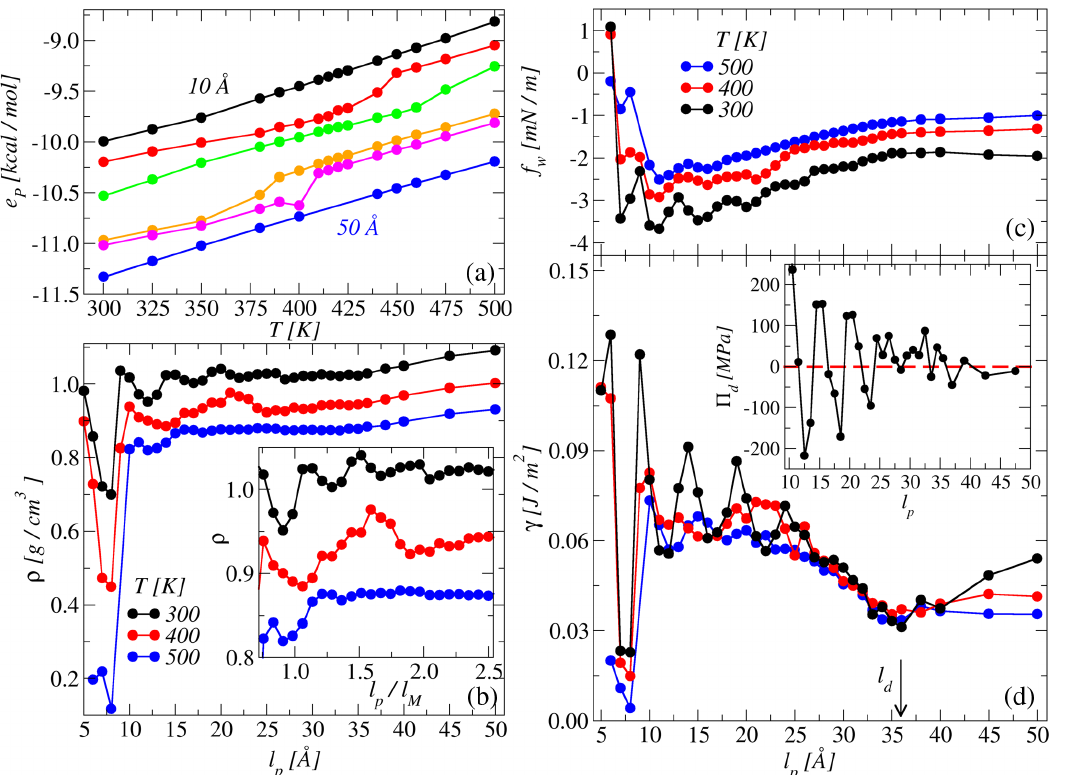
10 , 12, FIG. 1. T and l dependence of thermodynamic observables. (a) Total per-bead potential energy e as a function of T , for l p P p ¼ 14, 20, 22, 50 Å, from top to bottom. We observe a discontinuous behavior of the data at intermediate values of l , which points to the p crossing of T - and l -dependent phase boundaries. (b) l dependence of the IL mass density ρ in the pore, at the indicated values of T . p p These data also show important discontinuities and point to substantial layering. In the inset we show the same data, now as a function of =l the pore width normalized to the length of the cation, l , to highlight the dependence on cation geometry at the different p M temperatures. (c) l dependence of f , the energy of interaction with the pore walls normalized to the total surface of the interfaces, at p w the indicated values of T . (d) l dependence of the surface tension γ at the same values of T . These data allow us to be quantitative about p the wetting properties of the absorbed liquid phases. We also show l , indicated by the arrow. In the inset, we show the disjoining d pressure Π , calculated from the data for T ¼ 300 K, as described in the d